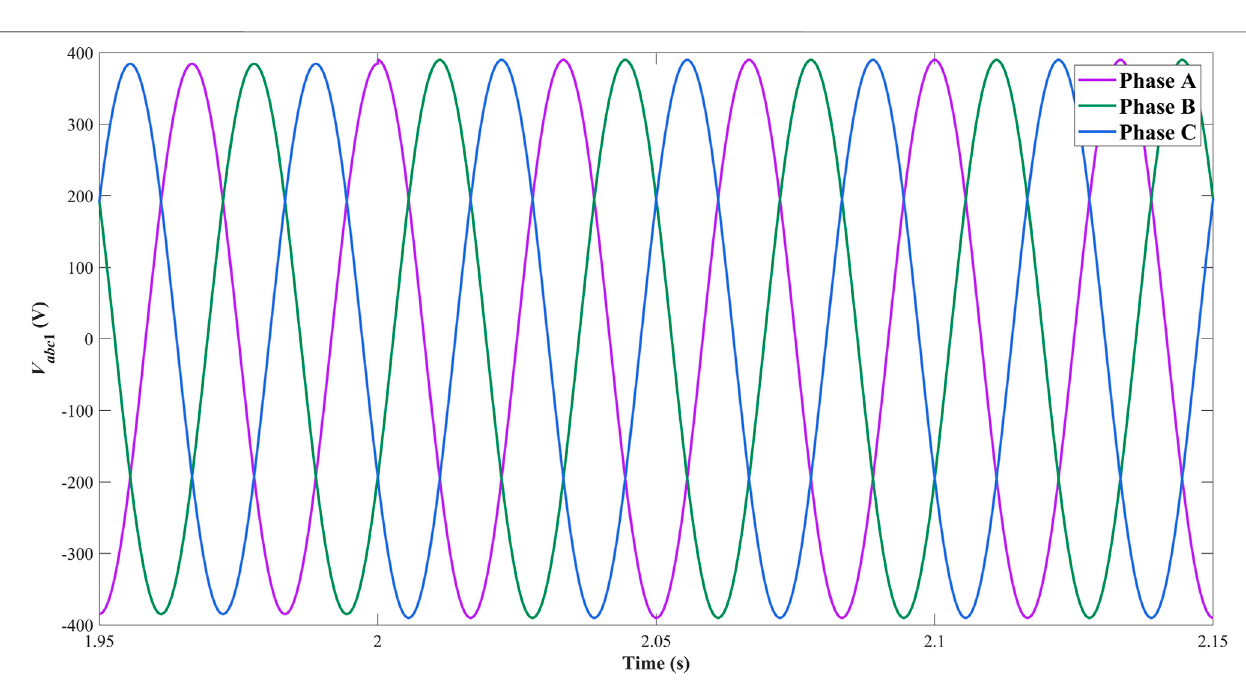
FIGURE 10 | Three-phase waveforms of PCC1